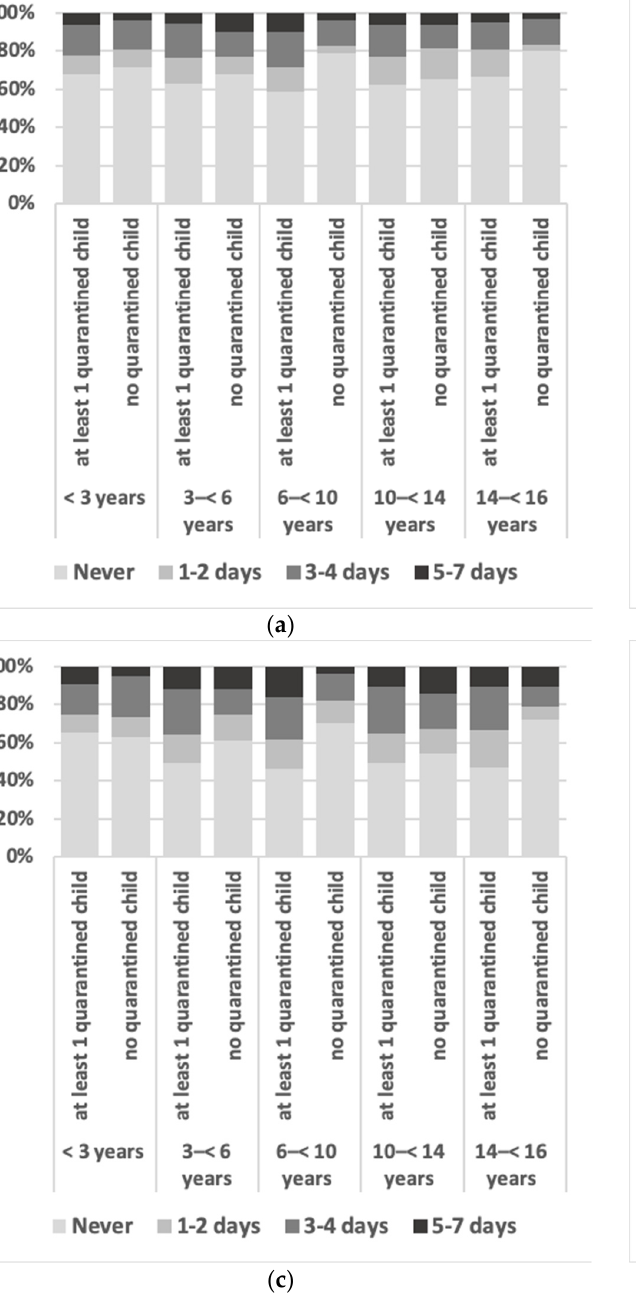
Figure 2. Frequency of symptoms reported by parents with at least one child in quarantine versus no child in quarantine; ( a ) frequency of children feeling nervous, anxious, or tense during the quarantine period; ( b ) frequency of children feeling down or depressed during the quarantine period; ( c ) frequency of children feeling lonely during the quarantine period; ( d ) physical reactions in children triggered by the quarantine period, such as sweating, shortness of breath or palpitations; never (light grey), 1–2 days (middle grey), 3–4 days (dark grey), 5–7 days (black); see text for p